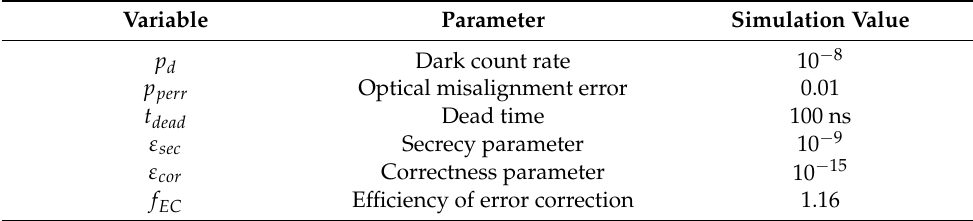
Table 1. Simulation parameters